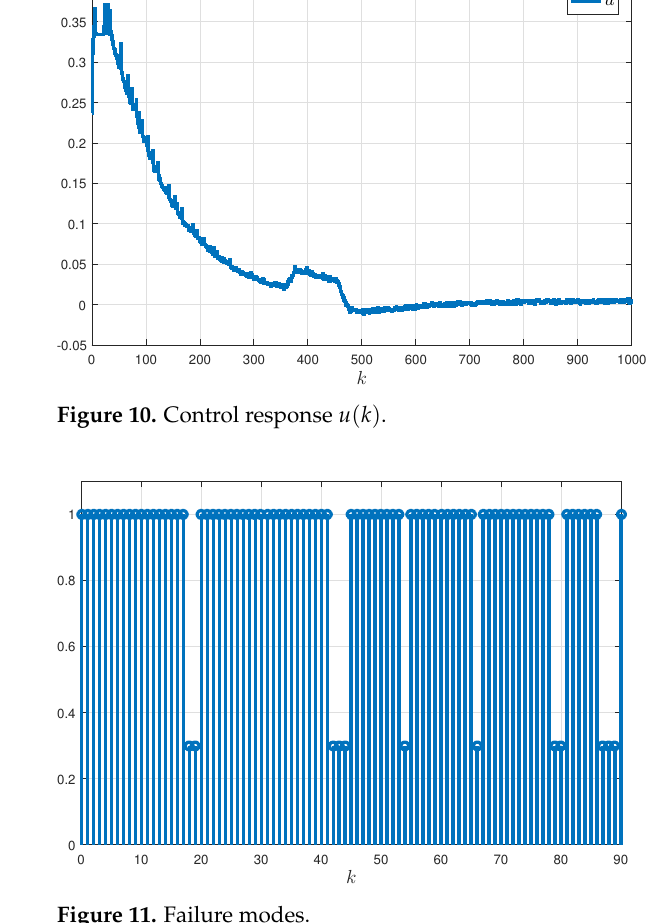
Figure 11. Failure